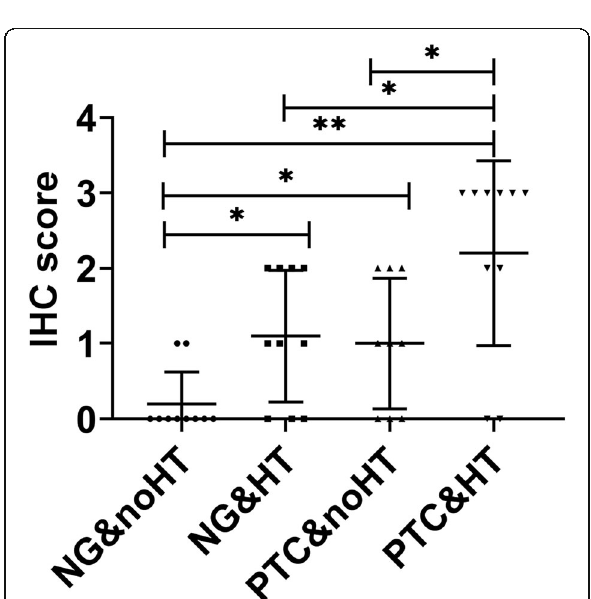
Fig. 6 Immunohistochemical results of PD-L1 expression in NG&noHT, NG&HT, PTC&noHT and PTC&HT tissue samples. Immunopositivity scores were classified as follows: 3+ (a score of 3), 2+ (a score of 2), 1+ (a score of 1), and negative (a score of 0) (*P < 0.05)